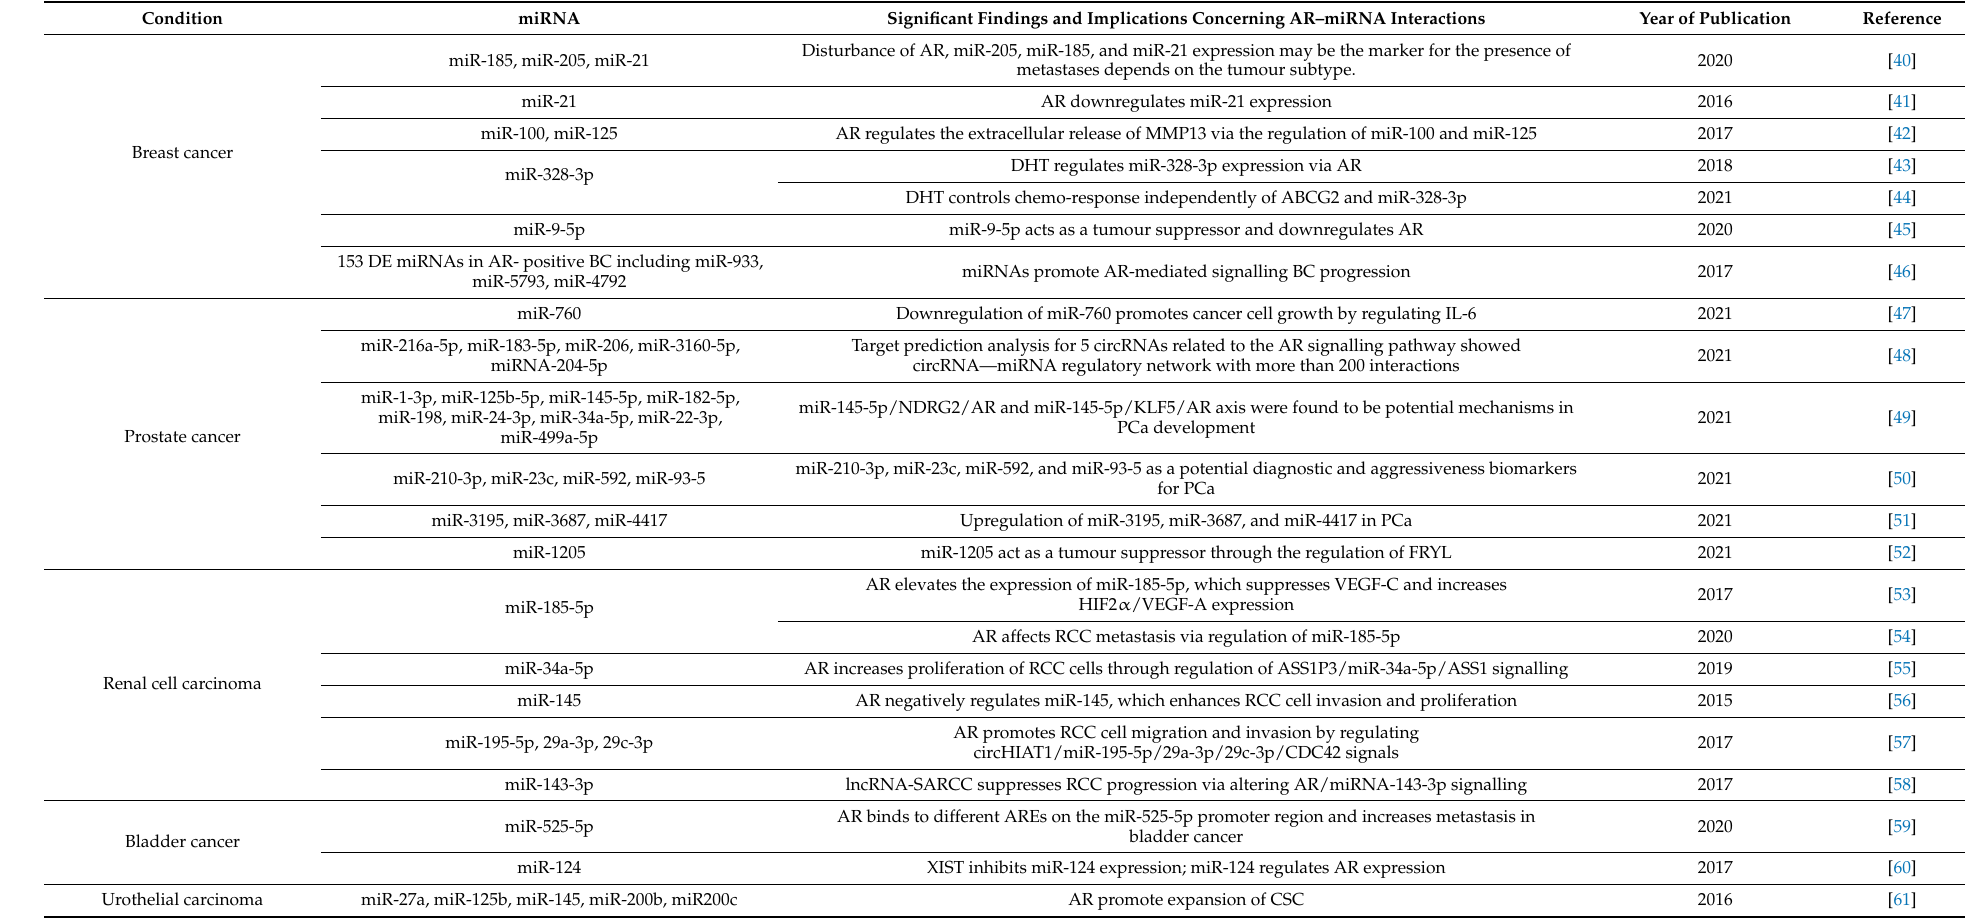
Table 1. The main new findings about miRNA–AR relation in different conditions in